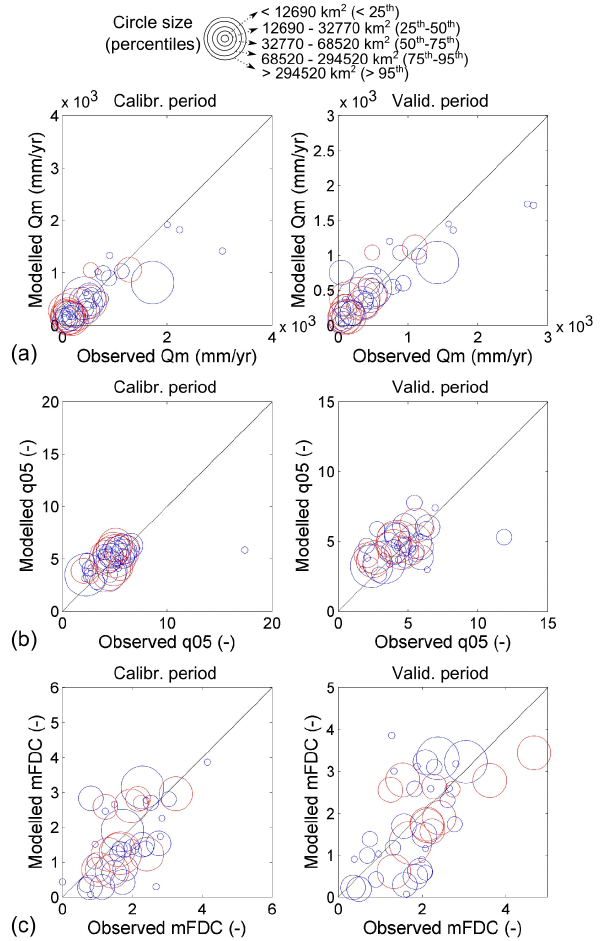
Figure 4. Signature analysis in the spatiotemporal model evalua- tion: (a) the mean annual specific runoff, (b) the normalised high flow statistic, and (c) the slope of the flow duration curve. Blue and red circles are used for the calibration and evaluation stations, re-